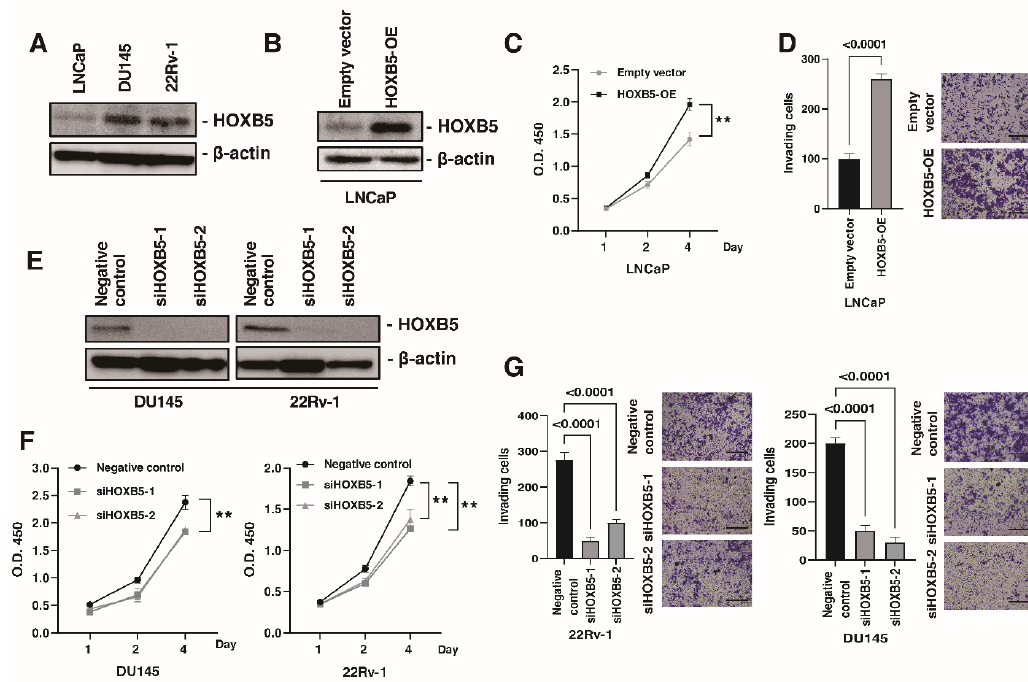
Figure 3. HOXB5 promotes cell growth and invasion in prostate cancer (PCa) cell lines. ( A ) Western blotting of HOXB5 in LNCaP, DU145, and 22RV-1 cells. β -actin was used as a loading control. ( B ) Western blotting of HOXB5 in LNCaP cells transfected with HOXB5 expressing vector and empty vector. β -actin was used as a loading control. ( C ) Cell growth assay in LNCaP cells transfected with HOXB5 expressing vector and empty vector. WST-1 assays assessed cell growth at 1, 2, and 4 days after seeding on 96-well plates. Bars and error bars indicate the mean and S.D., respectively, of three independent experiments. ** p < 0.01. ( D ) Cell invasion assay in LNCaP cells transfected with HOXB5 expressing vector and empty vector. Cell invasion was assessed using a modified Boyden chamber assay. Bars and error bars indicate the mean and S.D., respectively, of three independent experiments. Representative images of the invasion assay are shown. Scale bar, 100 µ m. ( E ) Western blotting of HOXB5 in DU145 and 22Rv-1 cells transfected with HOXB5 or negative control siRNAs. β -actin was used as a loading control. ( F ) Cell growth assay in DU145 and 22Rv-1 cells transfected with HOXB5 or negative control siRNAs. WST-1 assays assessed cell growth at 1, 2, and 4 days after seeding on 96-well plates. Bars and error bars indicate the mean and S.D., respectively, of three independent experiments. ** p < 0.01. ( G ) Cell invasion assay in DU145 and 22Rv-1 cells transfected with HOXB5 or negative control siRNAs. Cell invasion was assessed using a modified Boyden chamber assay. Bars and error bars indicate the mean and S.D., respectively, of three independent experiments. Representative images of the invasion assay are shown. Scale bar, 100 µ m.